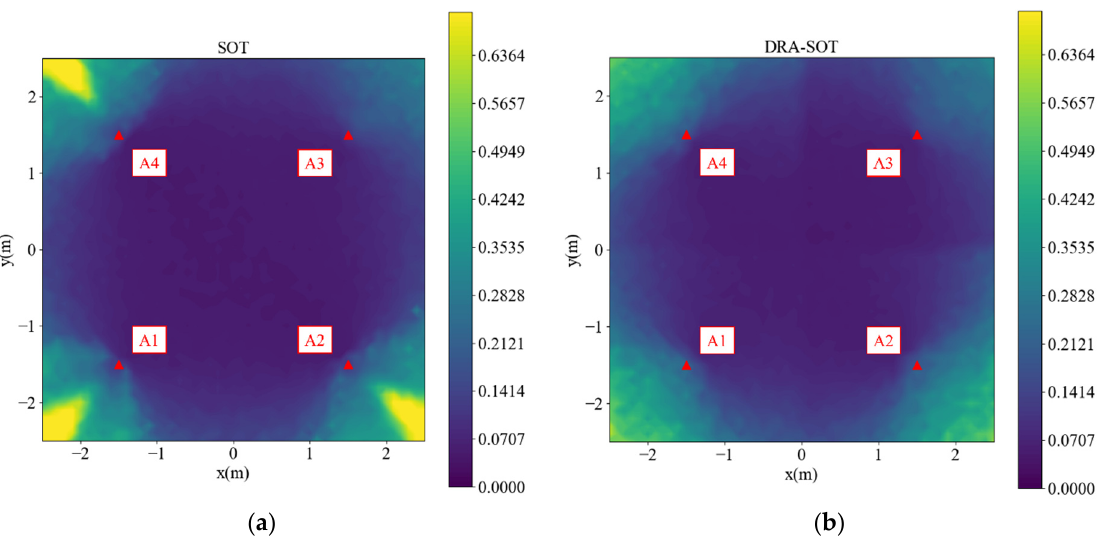
Figure 7. Simulated RMSE for square deployment using ( a ) SOT, ( b ) dynamic reference anchor SOT (DRA-SOT).